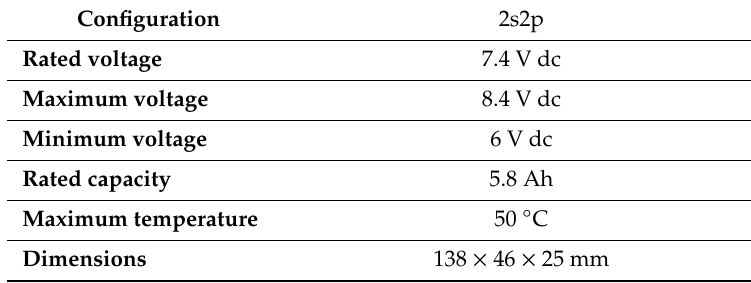
Table 3. Basic module specification of the Turnigy nano-tech 5800 mAh